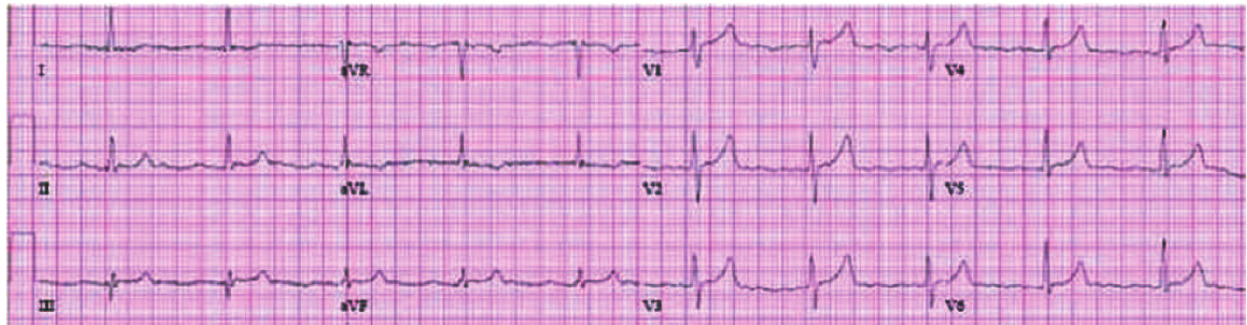
Fig. 1 - Postoperative electrocardiogram of patient 1 showing sinus rhythm with first degree atrioventricular block 3½ years after Maze